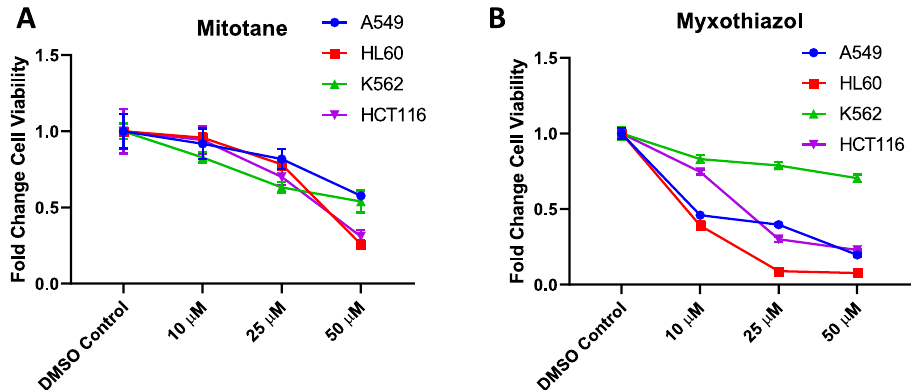
Figure 5. Effect of mitotane and myxothiazol in cell viability. Experimentally measured fold change in cell viability of four different cell-lines (A549, HL60, K562, HCT116) at different concentrations of mitotane and myxothiazol.